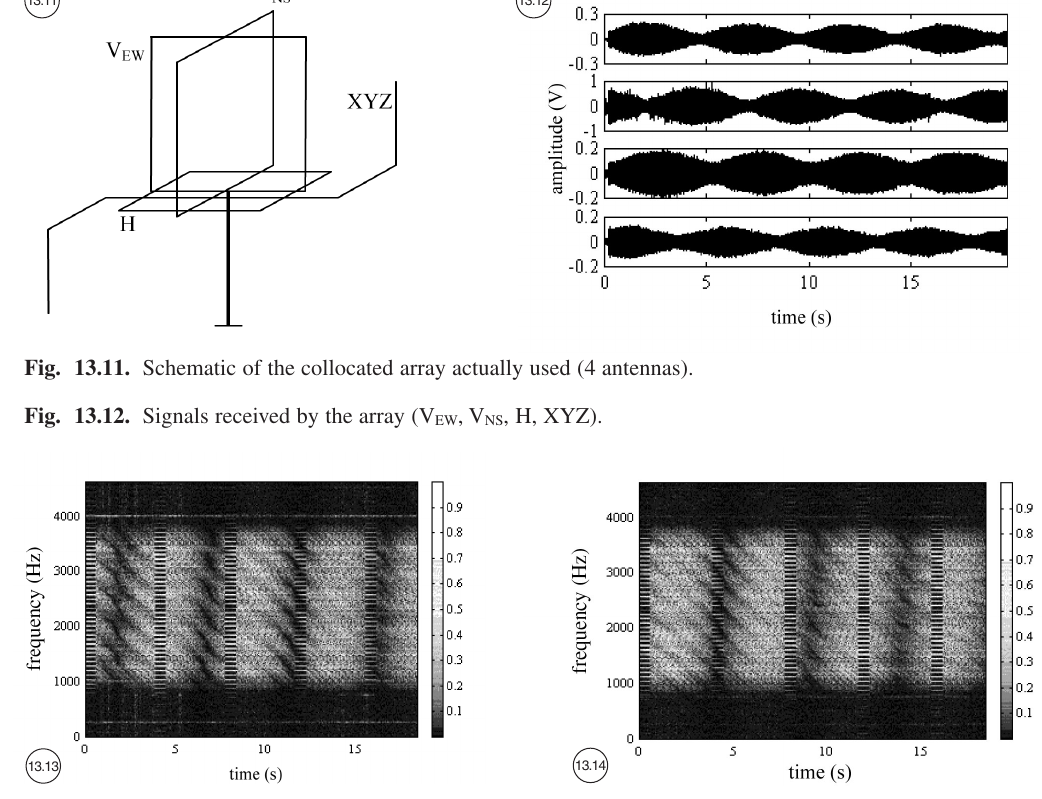
Fig. 13.13. Time-frequency analysis of the second channel at IF (V NS ). Fig. 13.14. Time-frequency analysis of the first channel at IF (V EW ).